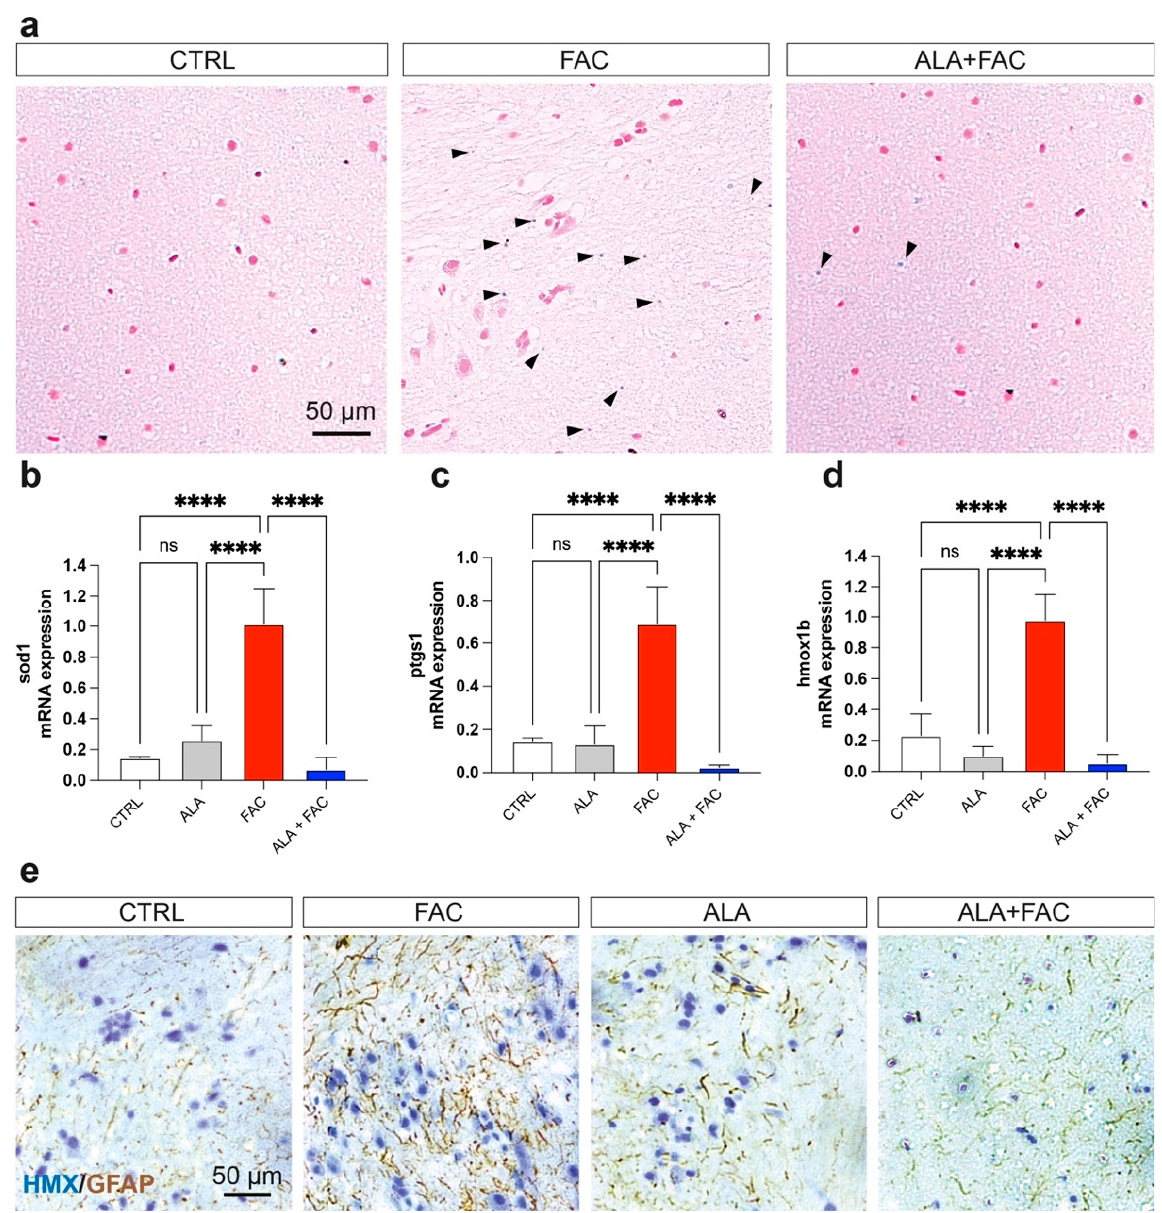
Figure 6. Iron exposition induces iron accumulation and gliosis in zebrafish brain. ( a ) Representative pictures of the brain stained with Perl’s Prussian Blue staining in control, FAC- and ALA + FAC- exposed zebrafish brain. ( b – d ) Quantification of mRNA expression levels of sod1 ( a ), ptgs1 ( b ) and hmox1b ( c ) in control, ALA-, FAC- and ALA + FAC-exposed zebrafish. ( e ) Representative pictures of the brain stained with hematoxylin and GFAP of control, FAC-, ALA- and ALA + FAC-exposed zebrafish. **** p -value < 0.0001.